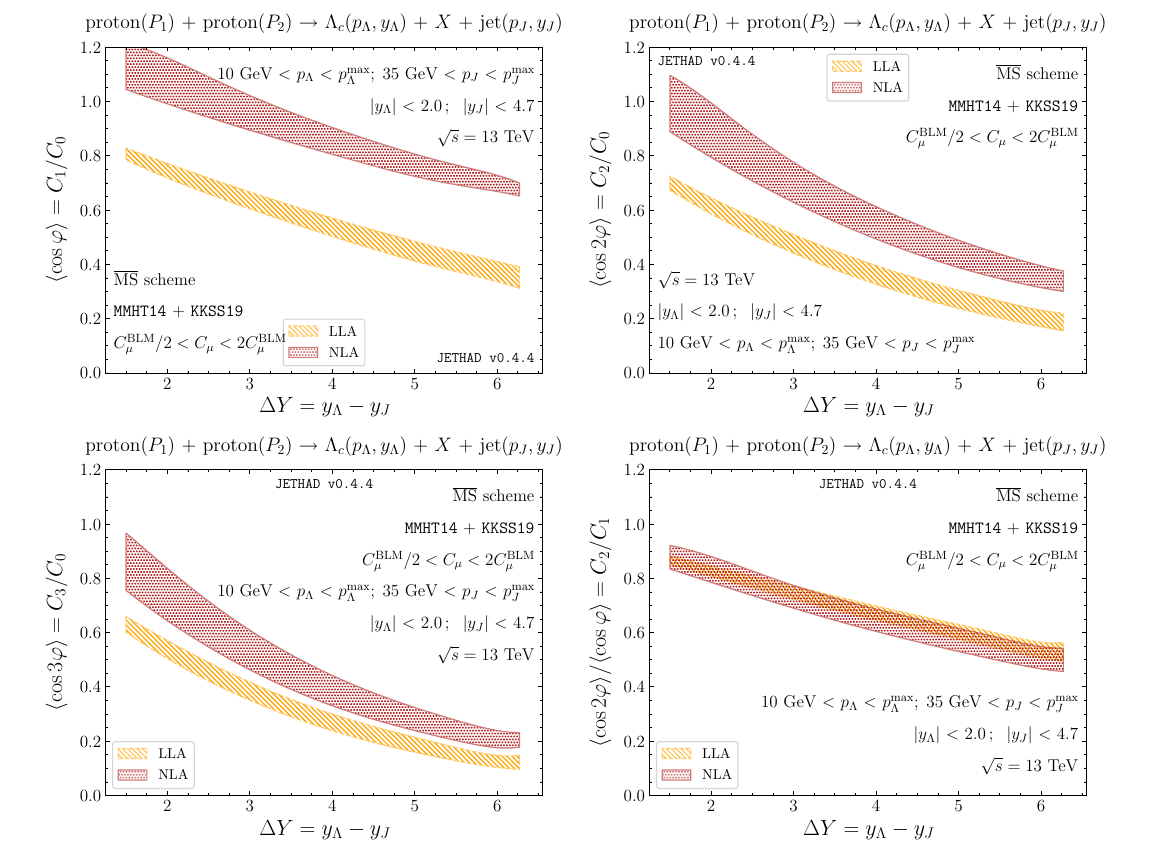
ing from scale variation and numerical integrations. Text boxes inside panels show transverse-momentum and rapidity ranges